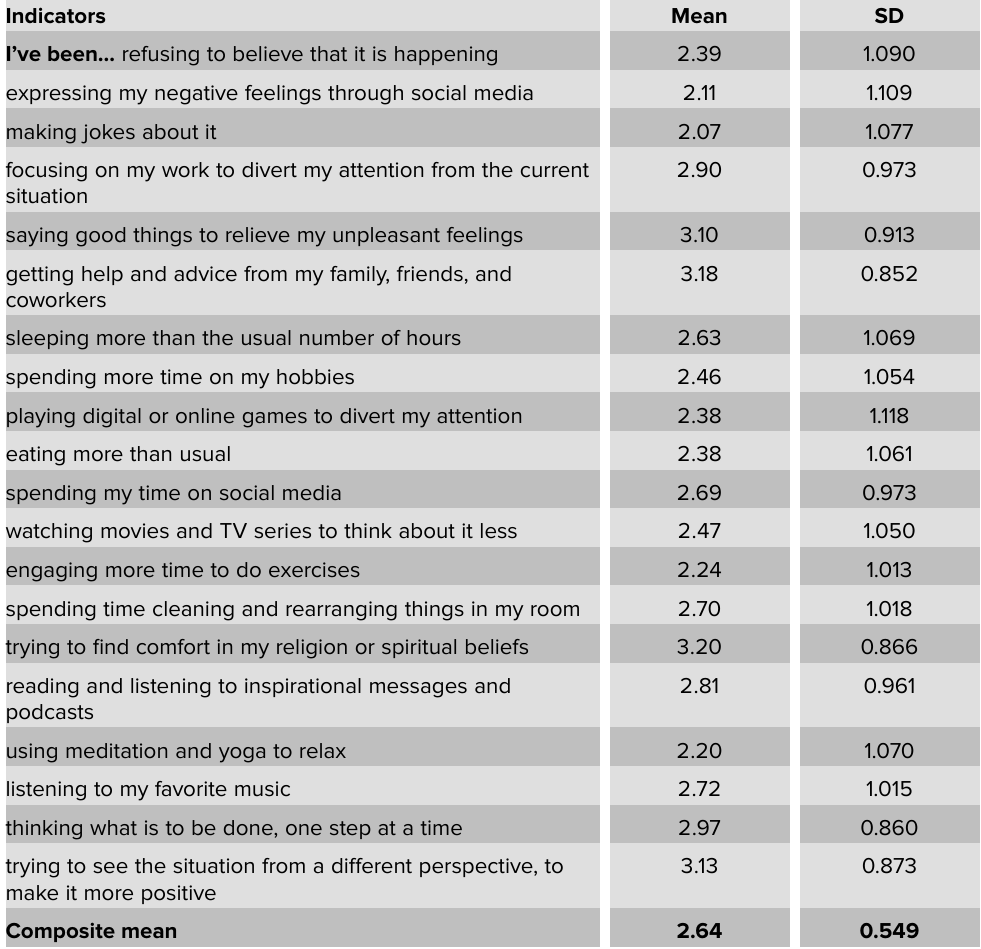
TABLE 3: Coping strategies of